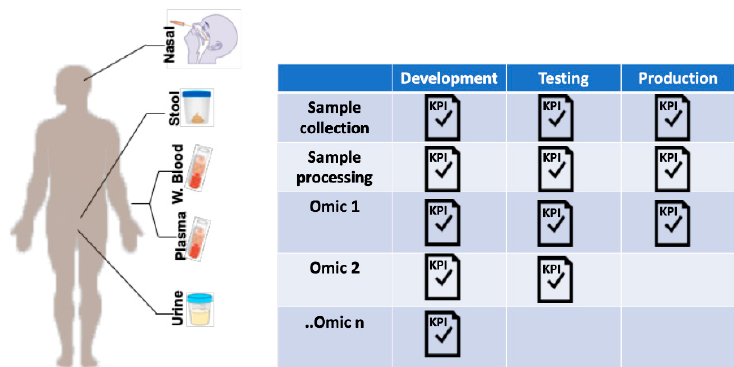
Figure 2. Production workflow for sample collection in multiomic studies. Standardization of sample